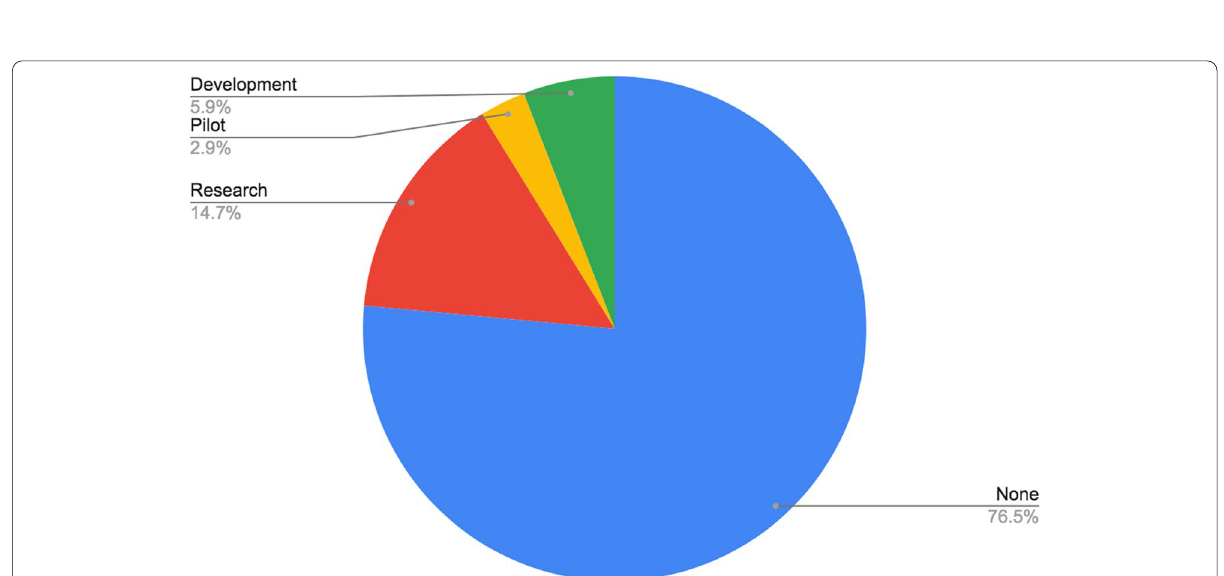
Fig. 2 C urrent application of blockchain technology on a company level. Note . Majority of business-respondents are not applying any blockchain technology in their firms. N =